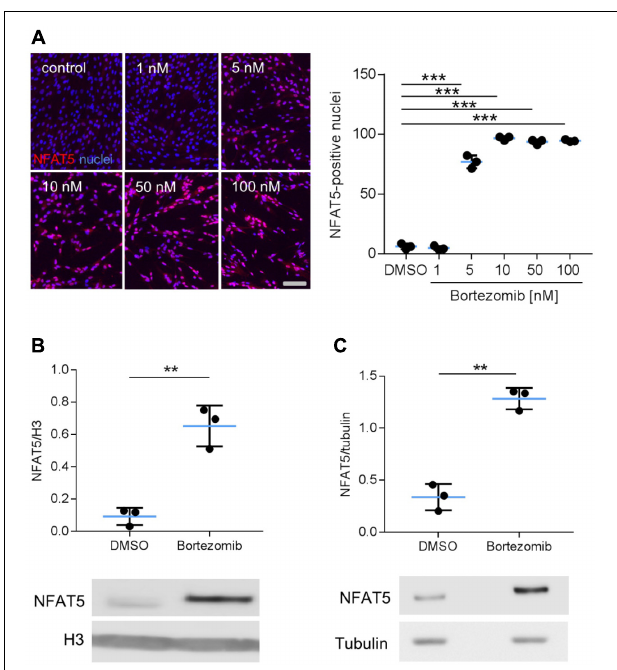
FIGURE 2 | Analysis of NFAT5 protein abundance upon inhibition of the proteasome. HUASMCs were treated (24 h) with increasing concentrations of bortezomib and NFAT5 was detected by immunostaining. The percentage of NFAT5-positive nuclei were quantified by automated image analysis ( A , ∗∗∗ p < 0.001, n = 3, one-way ANOVA and Tukey post-test; scale bar 100 µ m). NFAT5 protein abundance was determined after treatment with 10 nM bortezomib (24 h) in nuclear (B) and cytosolic ( C ) fractions of cell lysates ( B,C , ∗∗∗ p < 0.001/ ∗∗ p < 0.01 vs. DMSO, n = 3, unpaired, 2-tailed Student’s t -test; histone H3 and tubulin served as loading controls).